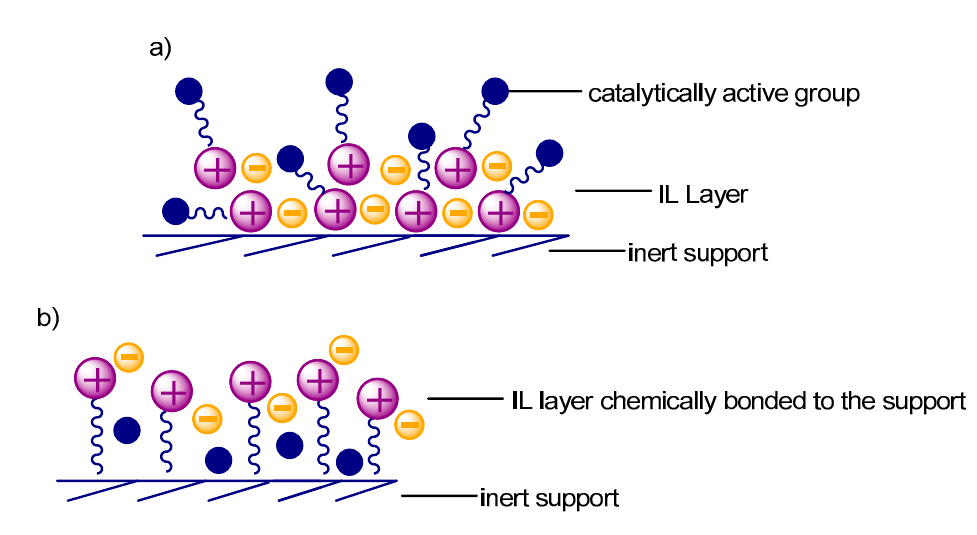
Figure 5. Methods of preventing catalyst from leaching: ( a ) By permanent bonding to ionic liquid; ( b ) by covalent bonding of ionic liquid to support.